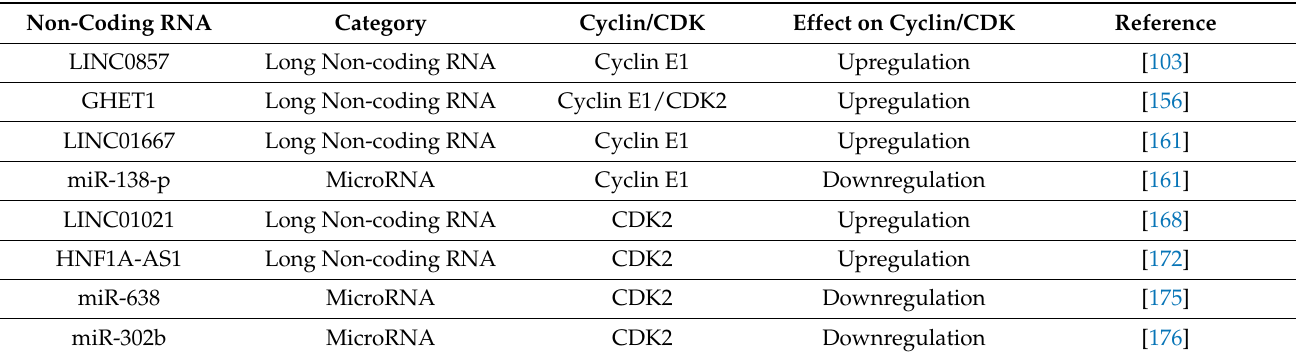
Table 6. Non-coding RNAs targeting the Cyclin E/CDK2 axis in gastric